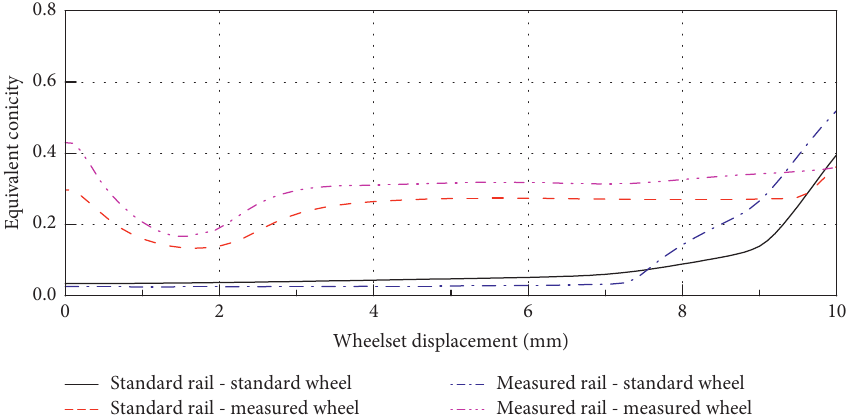
Figure 8: Four kinds of wheel-rail matching equivalent